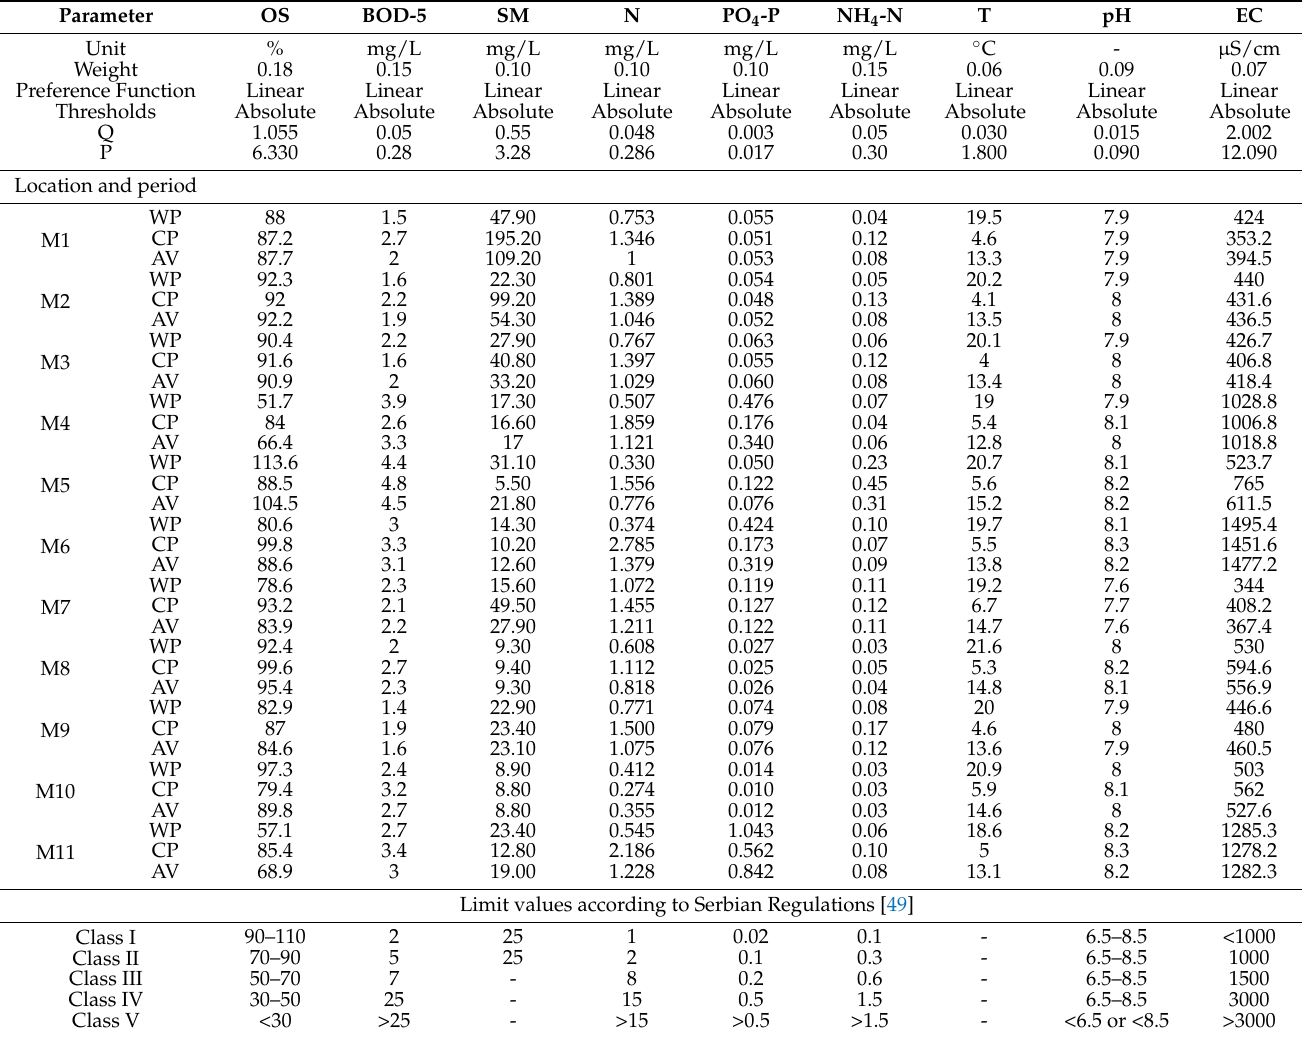
Table 1. Evaluation scenario with the average annual and periodic values of the water quality parameters at the observed locations. Parameter